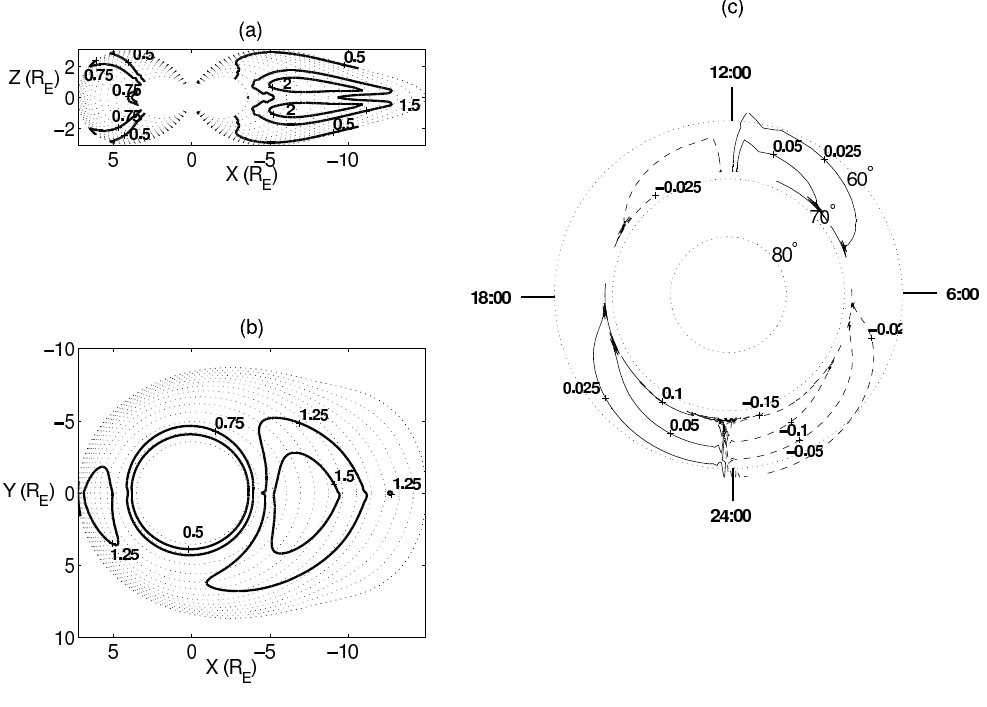
Fig. 11. Azimuthal current density J φ contours in the (a) noon-midnight and (b) equatorial planes for a 3-D equilibrium with anisotropic pressure; the dotted lines represent constant ψ contours; (c) Contours of constant J k in the ionosphere (at 1 R E ).